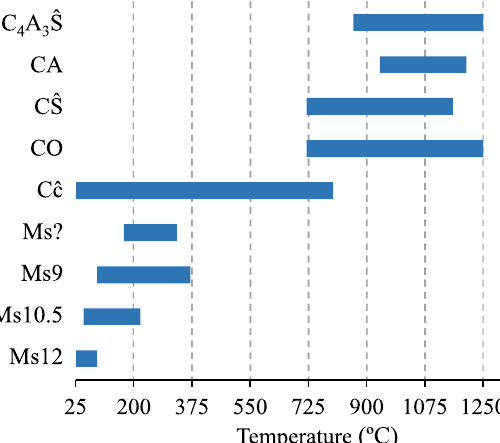
Figure 9. The ranges of crystalline phases developing in the thermal heating process of the synthesised sample detected by in-situ X-ray diffraction. Indexes: Ms – monosulfoaluminate (the number shows water content);